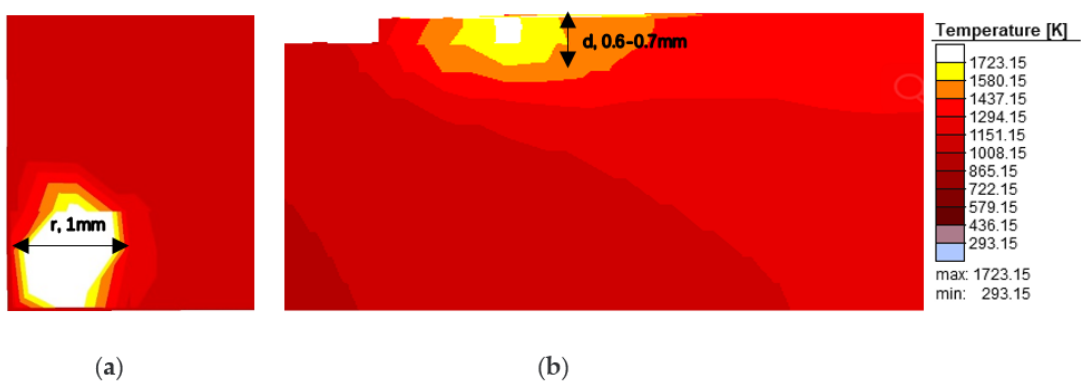
Figure 5. Morphology of molten pool under thermal action of the laser heat source: ( a ) Top view; ( b ) Section view.